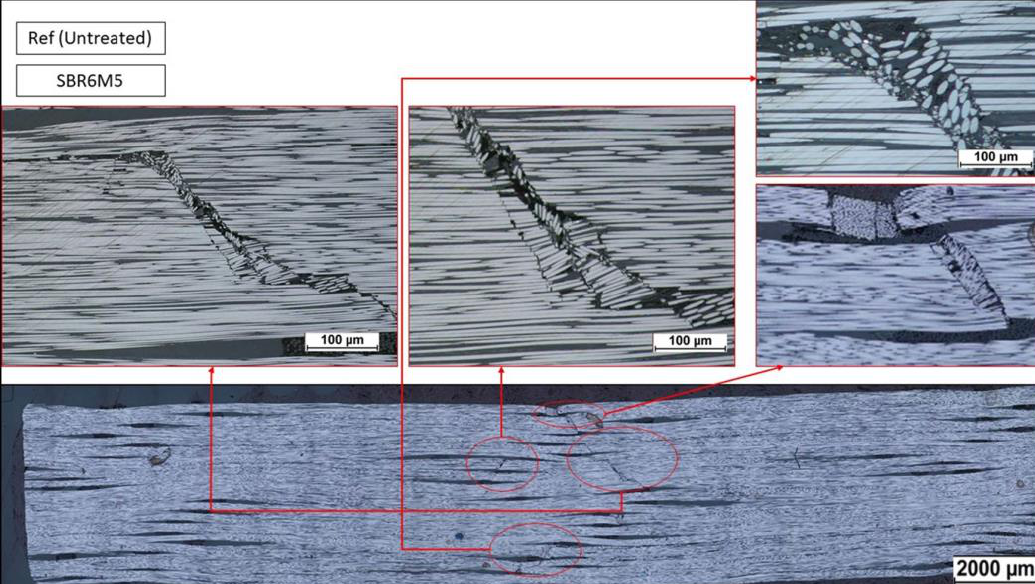
Figure 4. Micrograph of reference composite (composite reinforced with pristine CF fabric) short beam shear specimen after the test. The ( Bottom ) image shows an overview of the part of the specimen. ( Upper ) images indicate the fiber kinking that was formed during the failure.